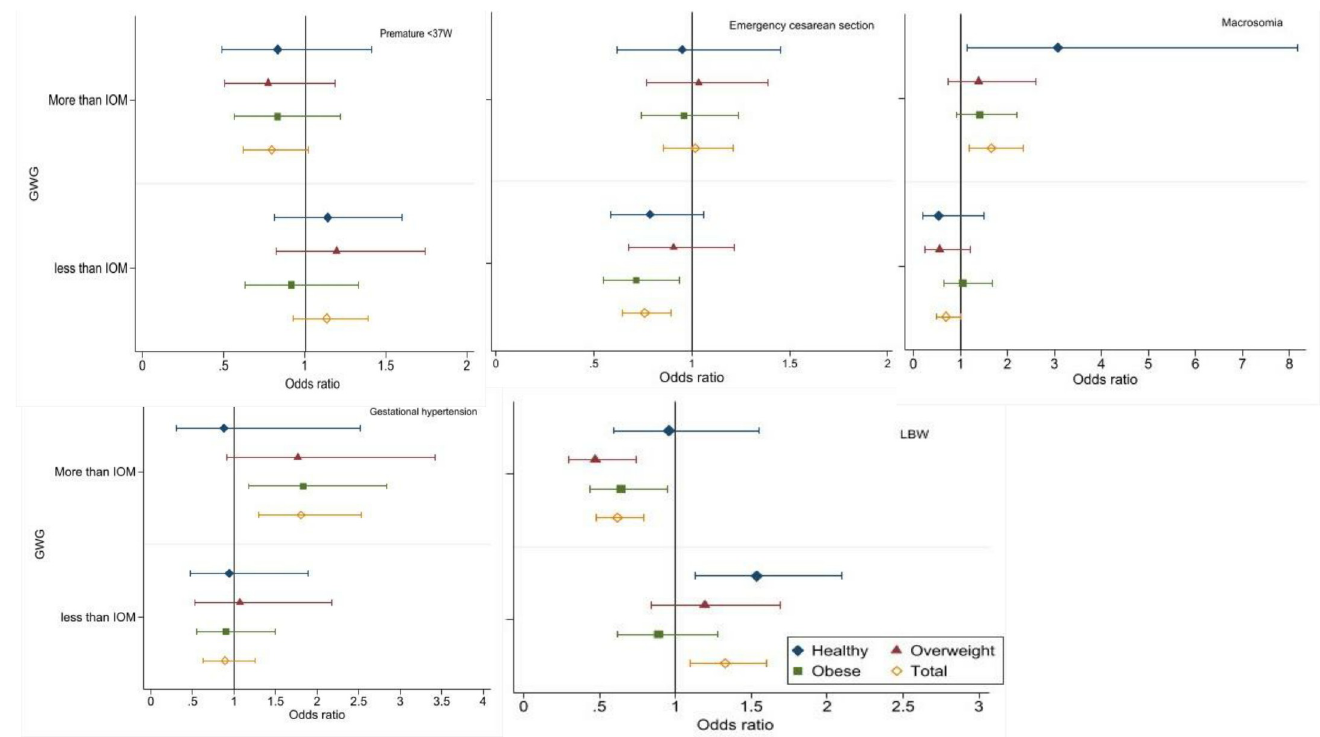
Fig 2. Association of pregnancy outcomes with gestational weight gain among participants according to the prepregnancy body mass index.